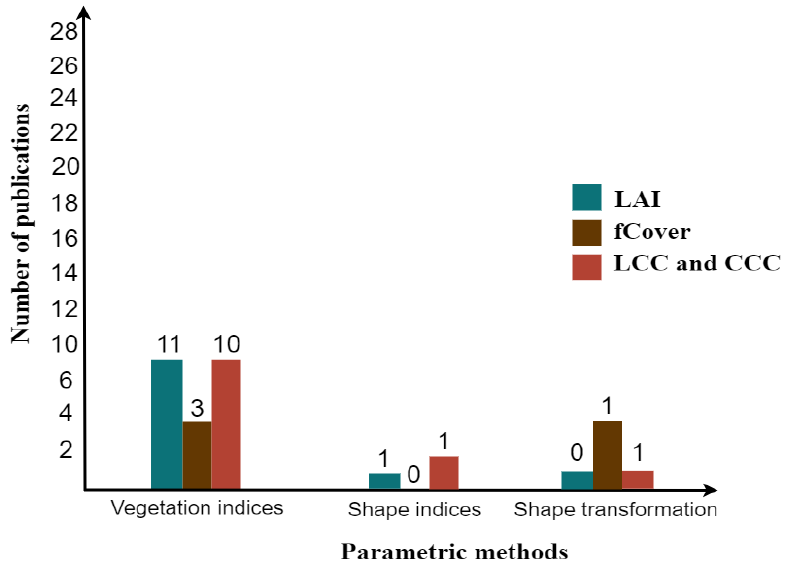
Figure 6. Bar chart of the most contributed parametric methods in a hybrid model.